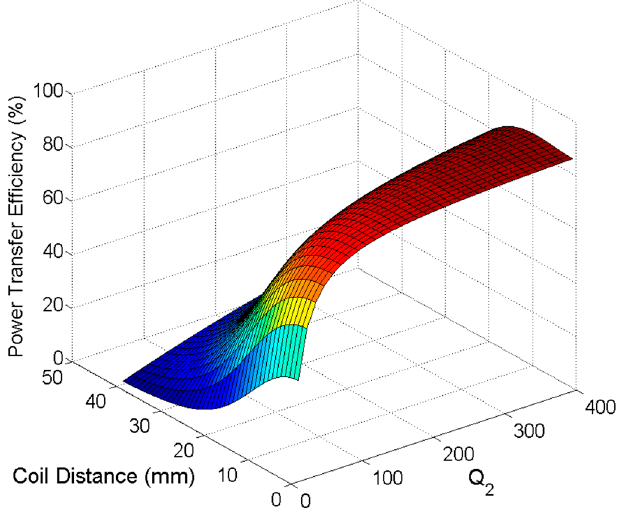
Figure 8. Efficiency versus Q-factor versus distance. Table 2. Initial Values.